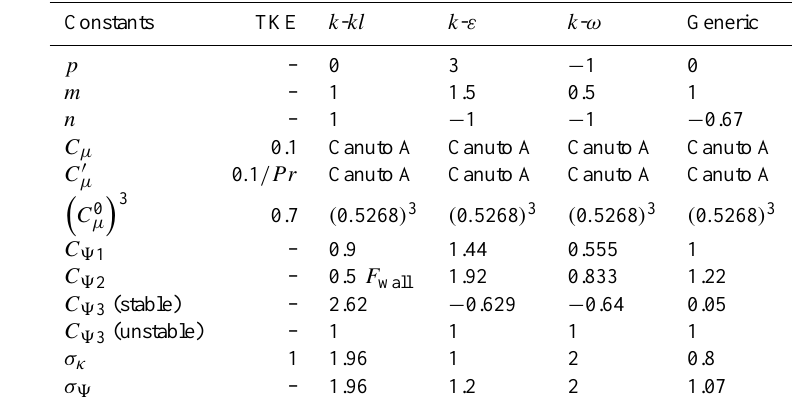
Table 1. Turbulence model